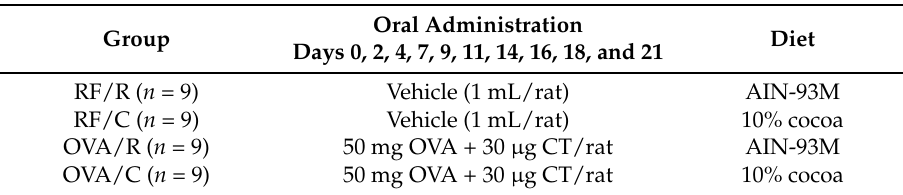
Table 1. Experimental design.